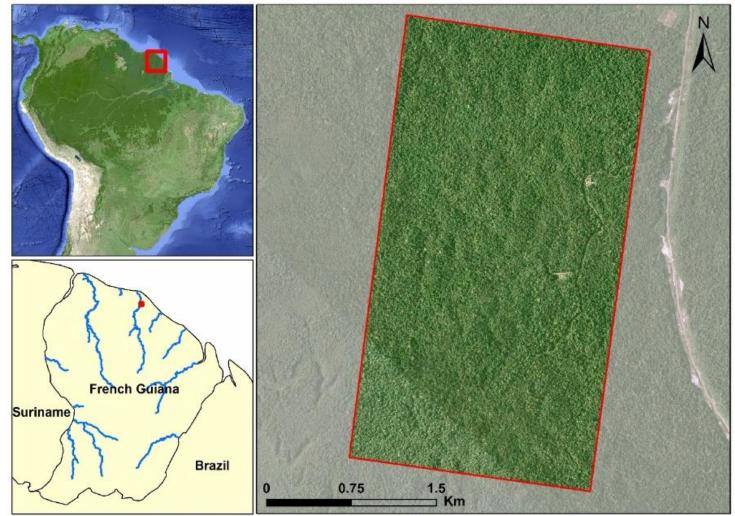
Figure 1. Study area